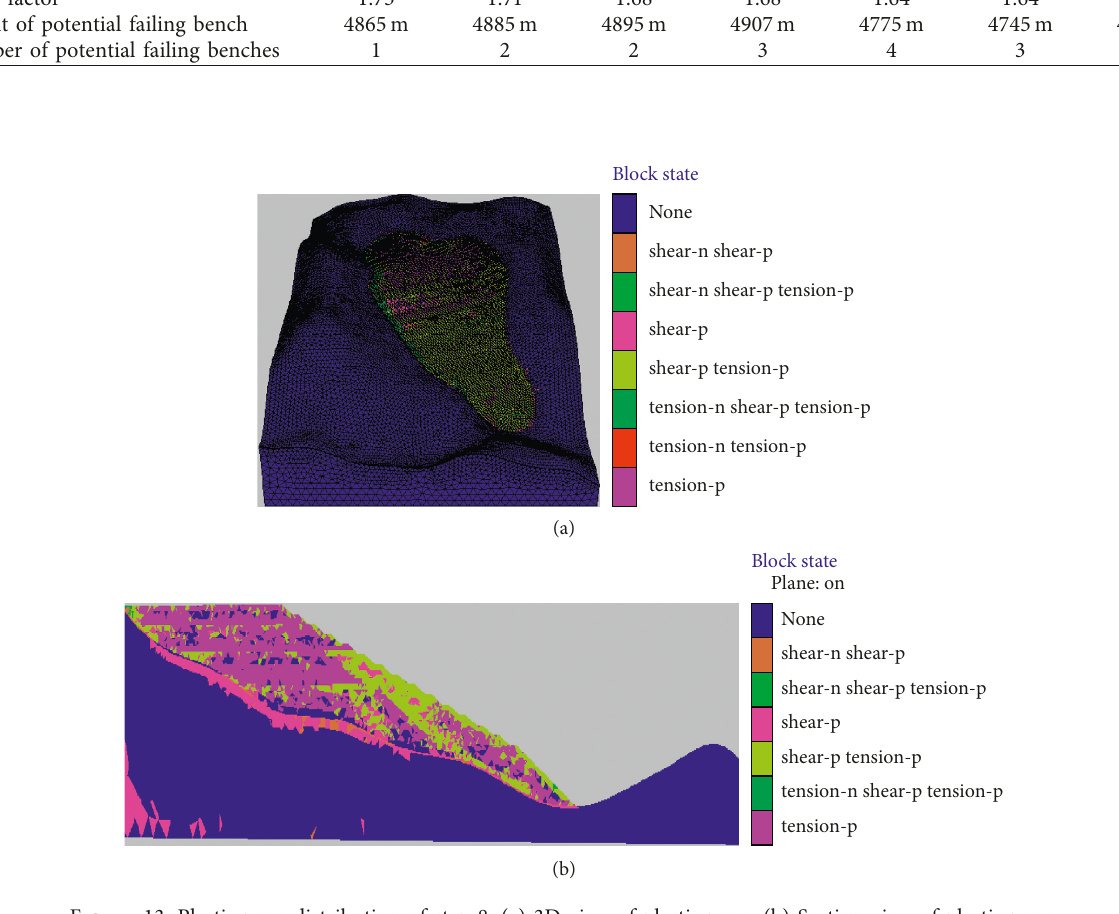
Figure 13: Plastic zone distribution of step 8. (a) 3D view of plastic zone. (b) Section view of plastic